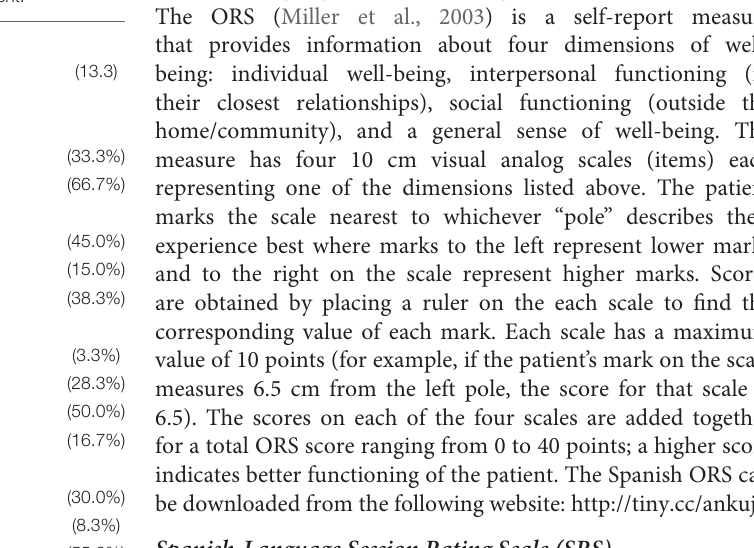
TABLE 1 | Demographic characteristics of patients before